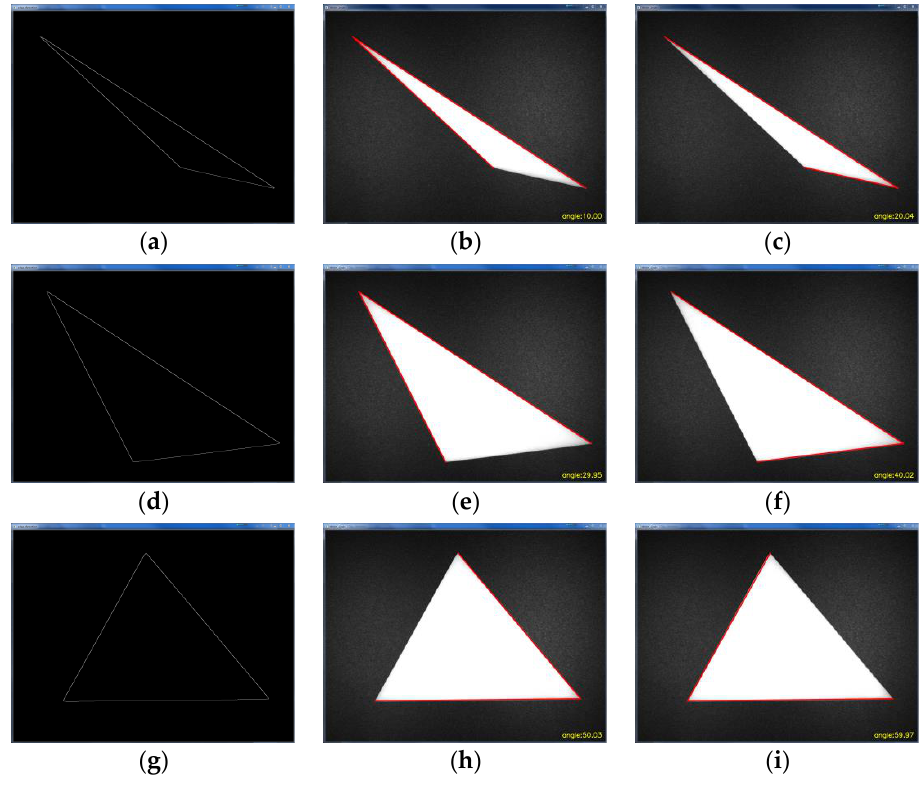
Figure 15. Angular value detection diagram: ( a ) First edge detection, ( b ) 10° angle detection, ( c ) 20° angle detection, ( d ) Second edge detection, ( e ) 30° angle detection, ( f ) 40° angle detection, ( g ) Third edge detection, ( h ) 50° angle detection, ( i ) 60° angle detection.